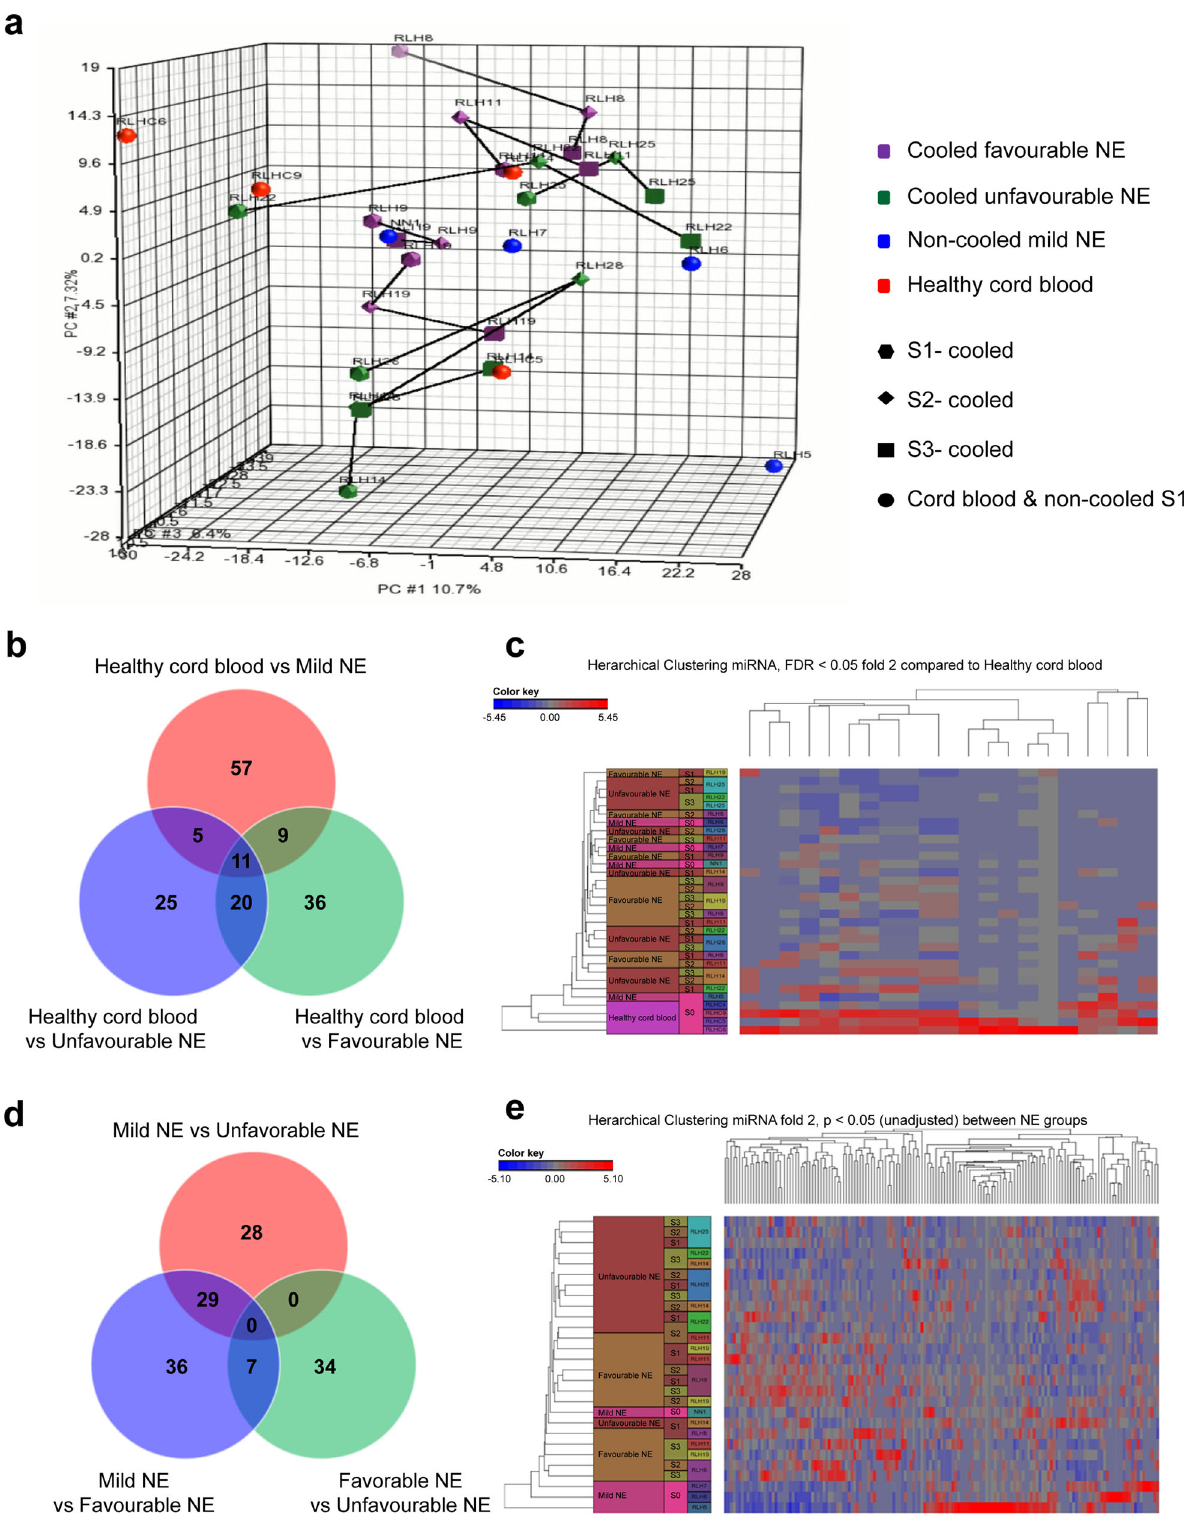
Fig. 1 Identi fi cation of candidate miRNA through miRNA next-generation sequencing. a PCA plot of all neonates examined with miRNA NGS according to their groups (Group 1A: moderate to severe NE with TH and favourable outcome (purple hexagon; S1, purple diamond; S2, purple square; S3), Group 1B: moderate to severe NE with TH and unfavourable outcome (green hexagon; S1, green diamond; S2, green square; S3), Group 2: mild NE without TH (blue circle), and Group 3: umbilical cord blood of healthy neonates (red circles). b Venn diagram showing the number of signi fi cant differential expression of miRNA between all three groups with umbilical cord blood. c Heatmap of all neonates in miRNA NGS with 17 signi fi cant miRNAs. d Venn diagram showing the differential expression of miRNA between all three groups excluding umbilical cord blood. e Heatmap of all neonates in miRNA NGS excluding umbilical cord blood showing no signi fi cant